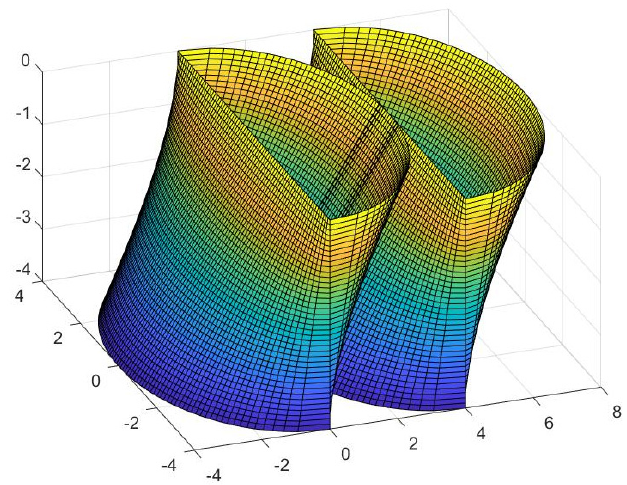
Figure 36. The Dyosphera standing on one of its four bases.